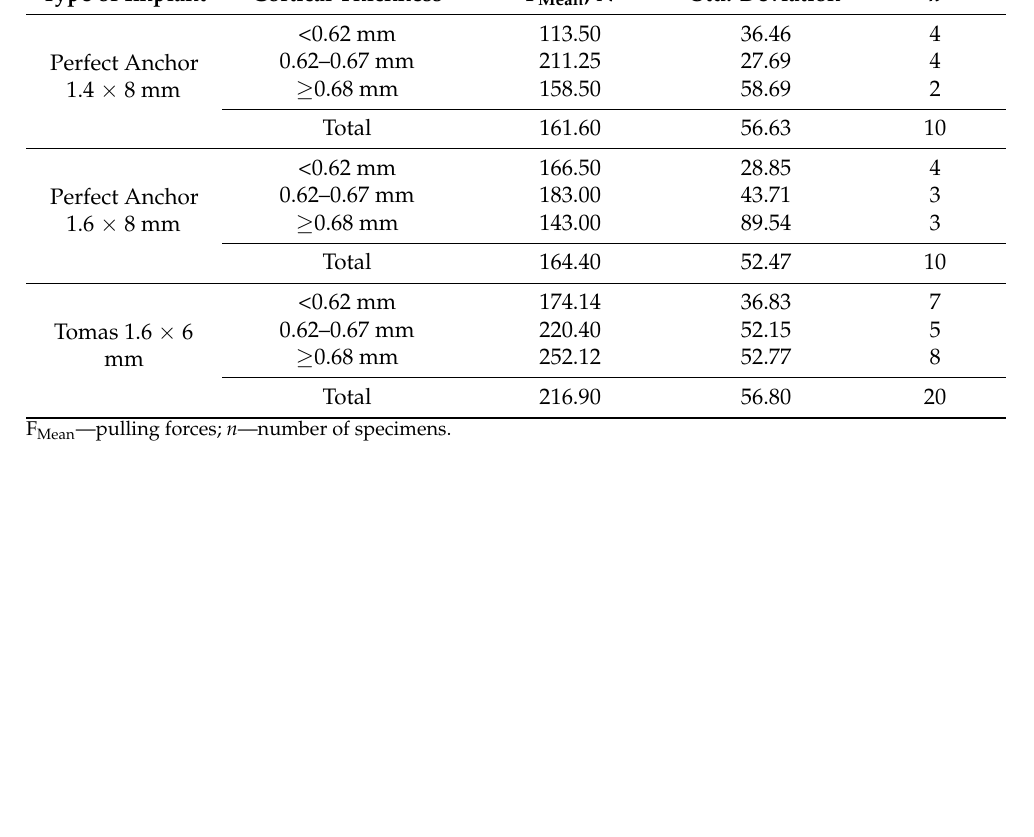
Table 2. Descriptive statistical values of the pulling force by implant type and cortical thickness. Type of Implant Cortical Thickness F Mean , N Std. Deviation Perfect